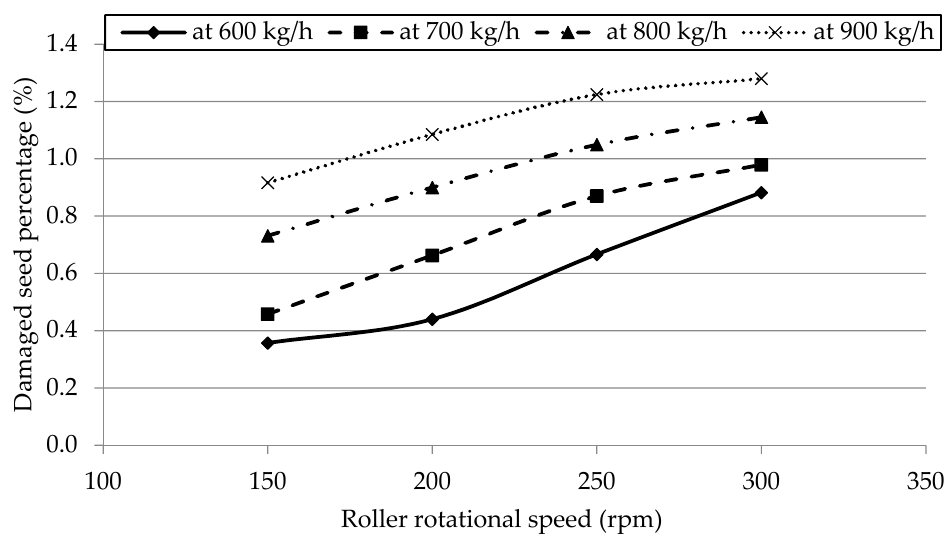
Figure 4. Effect of the roller’s rotational speed (rpm) on the damaged seed percentage (%) at different feeding rates